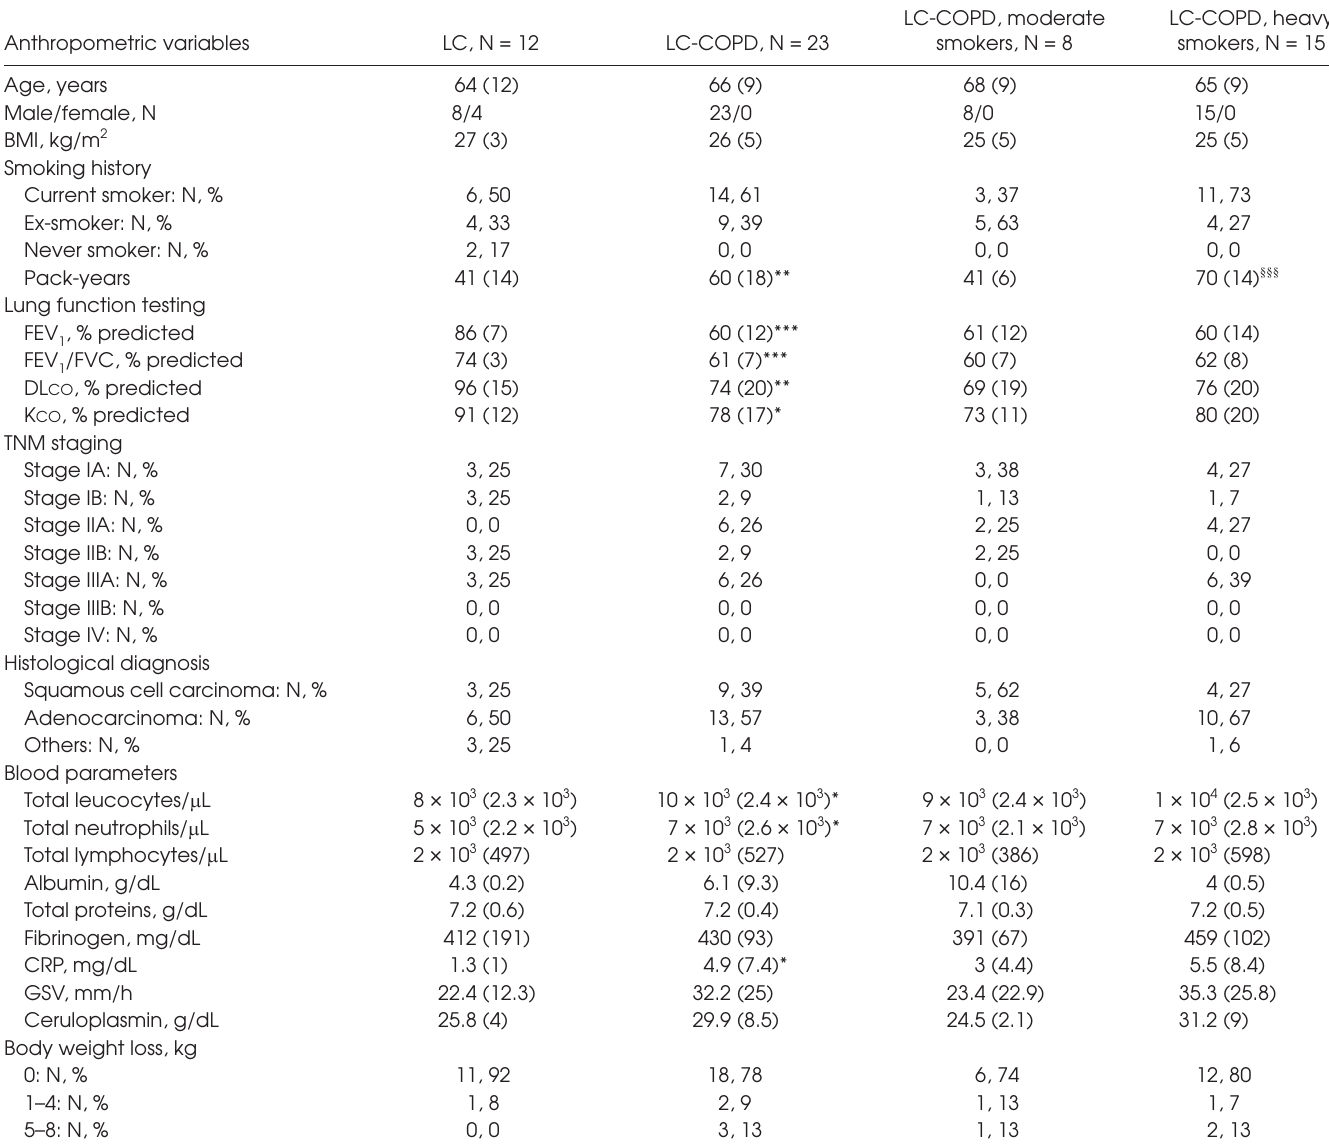
table 2. Clinical and functional characteristics of the study patients undergoing thoracotomy. a,b